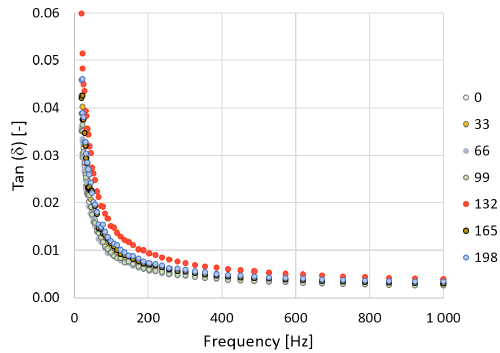
Figure 7. TPE-E—measurement course of the loss factor in dependence on frequency.